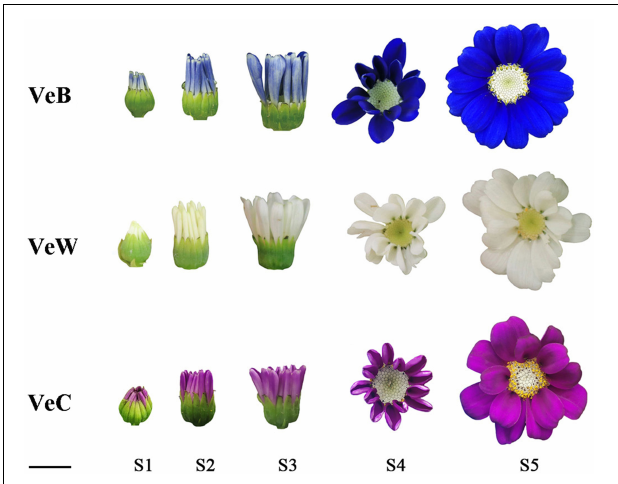
FIGURE 1 | The five different developmental stages (S1–S5) of the VeB, VeW, and VeC capitulum. Bar, 1